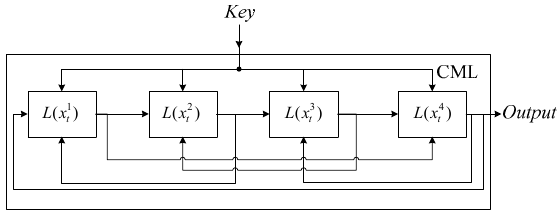
Figure 7. The structures of the improved four stage CML based on the logistic map.